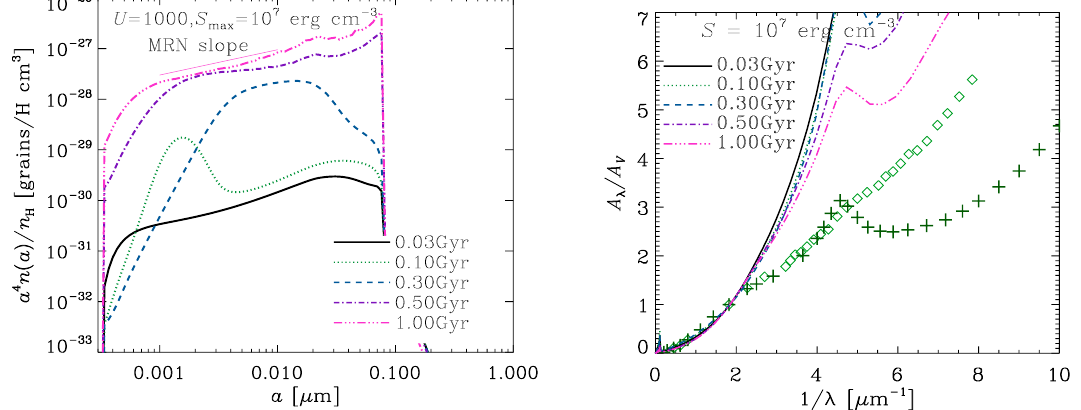
Figure 16. Evolution of grain size distribution (left panel) and extinction curve (right panel) for the starburst model. The solid, dotted, dashed, dot–dashed, and triple-dot–dashed lines show the grain size distributions at t = 0.03, 0.1, 0.3, 0.5, and 1 Gyr, respectively. The thin dotted line shows the MRN slope. We adopt a typical value S max = 10 7 ergcm − 3 and fix U = 1000. In the right panel, crossed and squared symbols show the MW and Small Magellanic Cloud (SMC) extinction curves. From Hirashita and Hoang